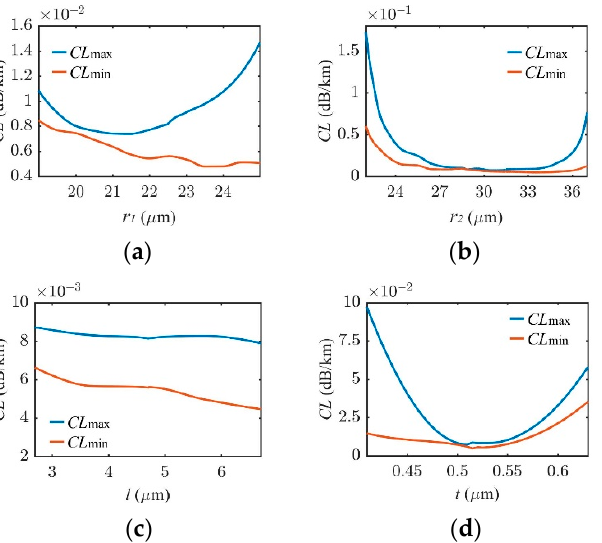
Figure 5. ( a ) Change in CL with r 1 ; ( b ) Change in CL with r 2 ; ( c ) Change in CL with l ; ( d ) Change in CL with t .